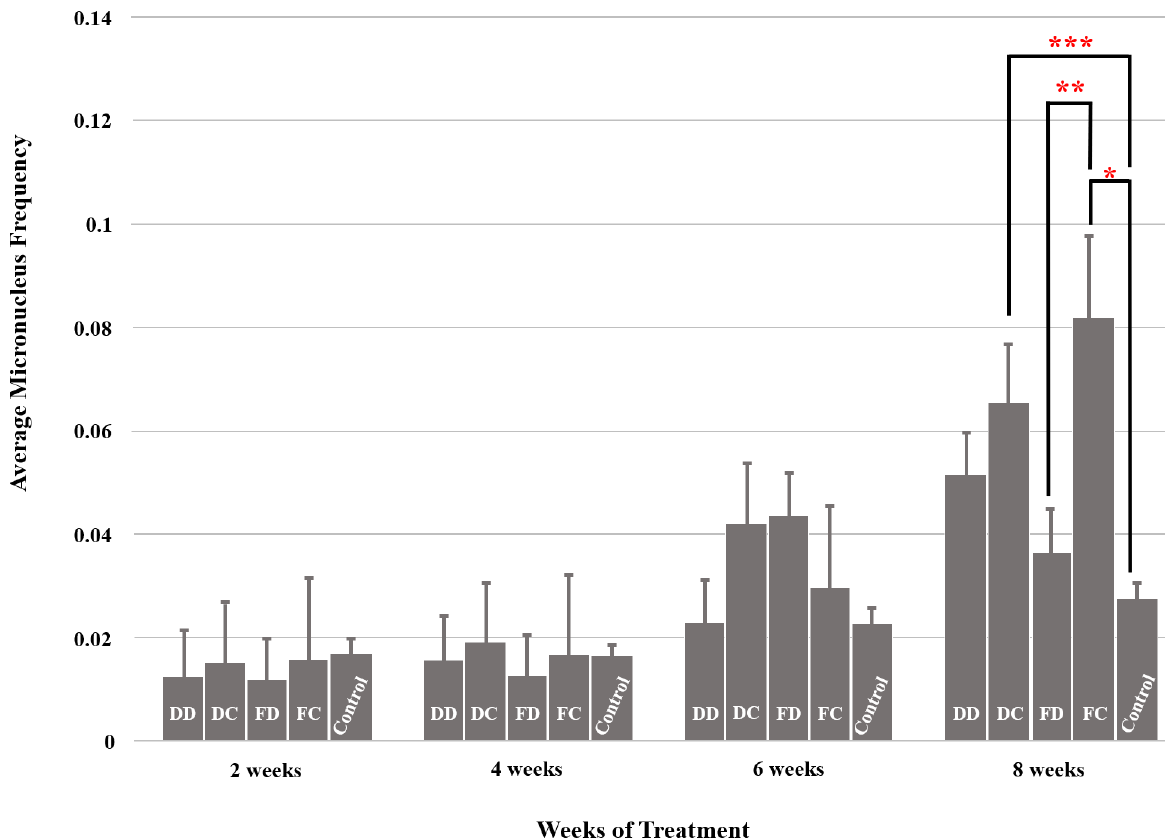
Figure 2. Representative Average frequencies of micronucleated polychromatic erythrocytes (MPCEs) in weeks of treatment. DD = group treated with 30 mg/kg decoction; DC = group treated with 60 mg/kg decoction; FD = group treated with 30 mg/kg freeze-dried extract; FC = group treated with 60 mg/kg freeze-dried extract; C = control group treated with only distilled water. Significant differences (p<0.05) between groups are indicated by